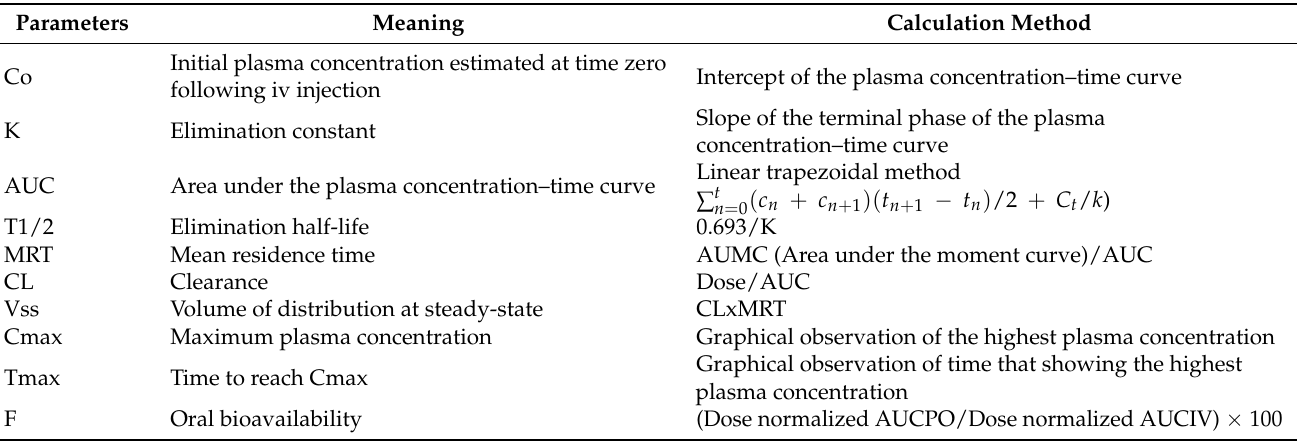
Table 1. Toxicokinetic parameters and calculation